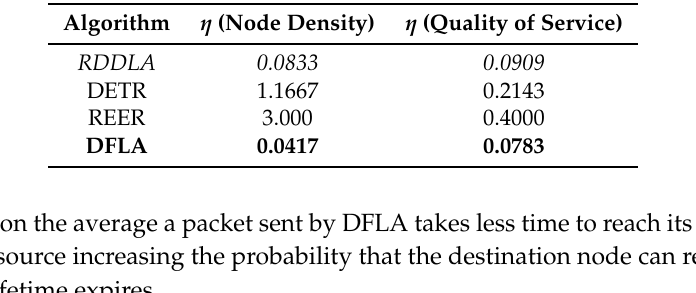
Table 4. η ( ϕ ) for the impact of node density and quality of